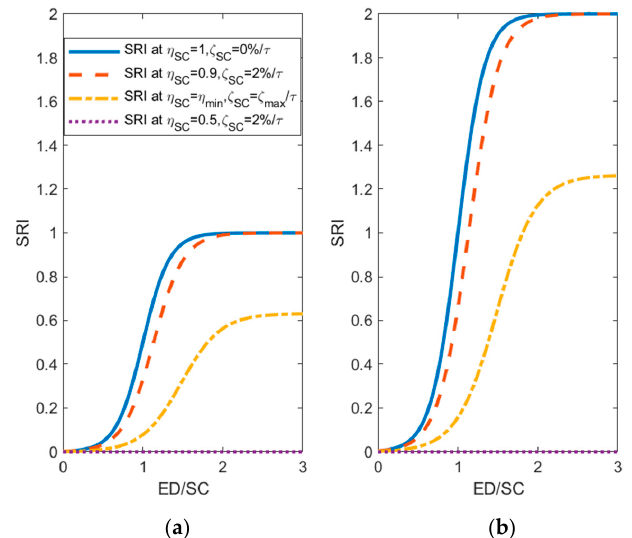
Figure 3. Pinch-off characteristics relating to k with Activity Coefficient 1 ( a ) and Activity Coefficient 2 ( b